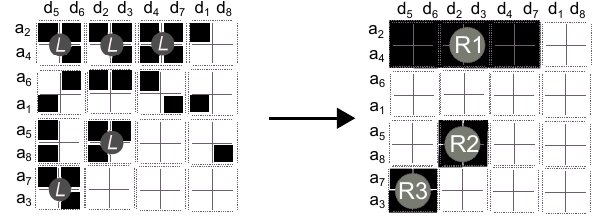
Figure 5. Step 5. Example of merging 2 × 2 labelled square cells. To better illustrate the result from the method we have labelled each region.